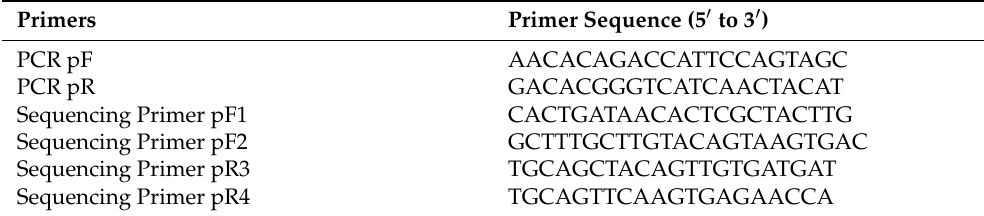
Table 1. RT-PCR and Sanger sequencing primers for the identified ORF7a deletion.